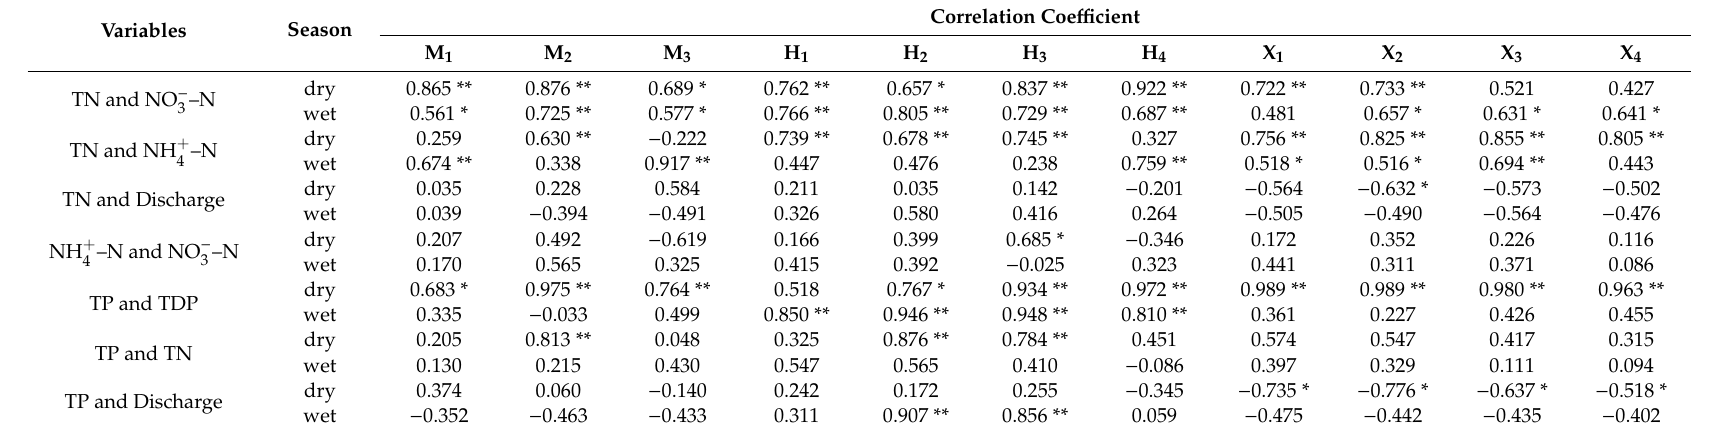
Table 2. The Pearson correlation coe ffi cient between variables in the dry season (n = 10) and wet season (n = 12).